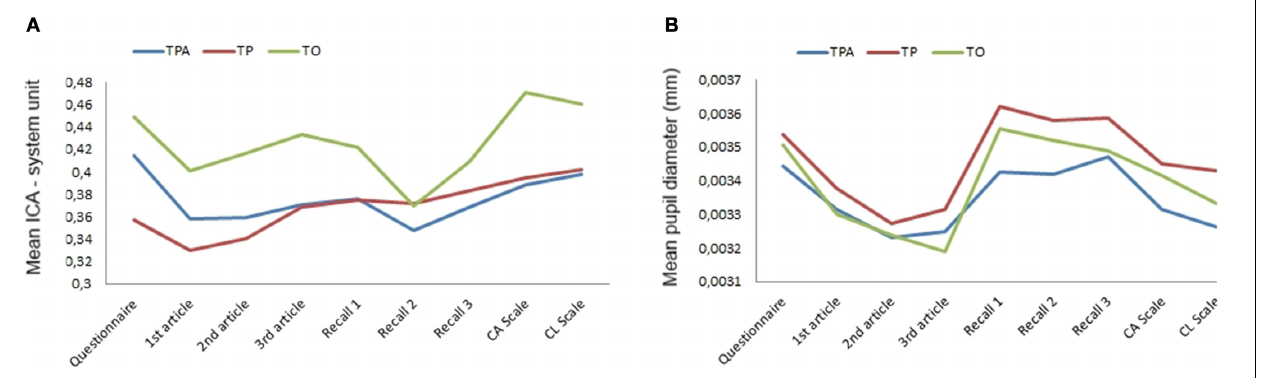
Frontiers in Psychology | Quantitative Psychology and